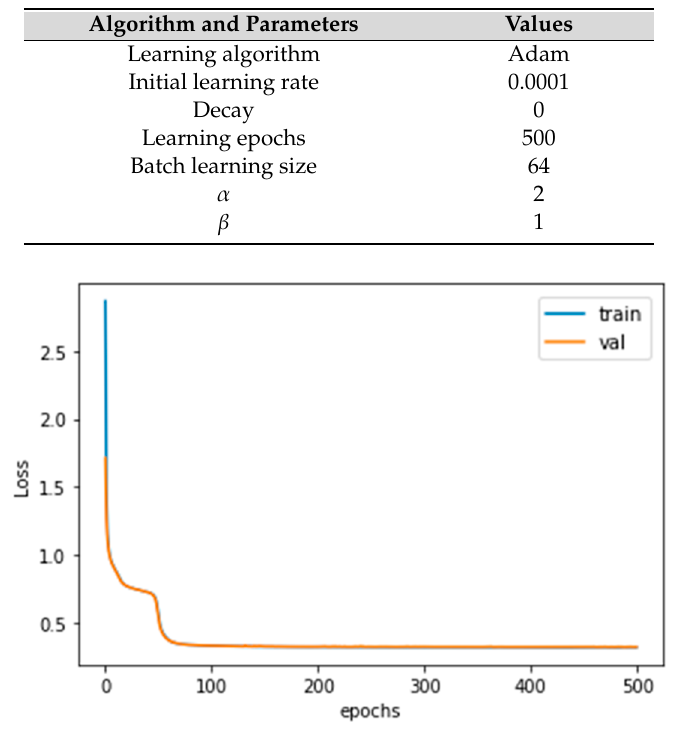
Figure 16. The training loss history.